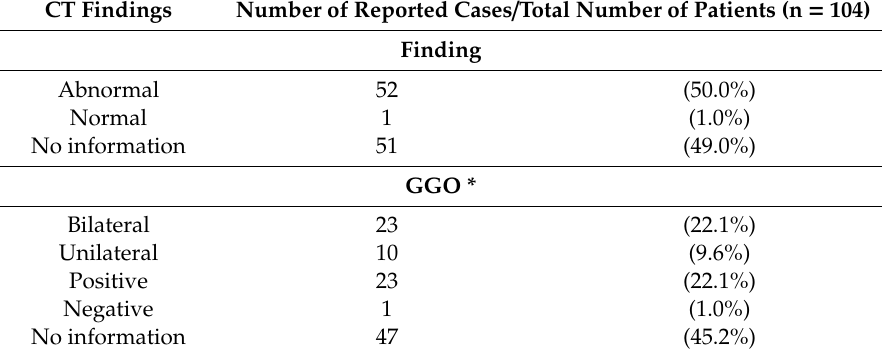
Table 4. CT findings of pregnant patients with COVID-19.